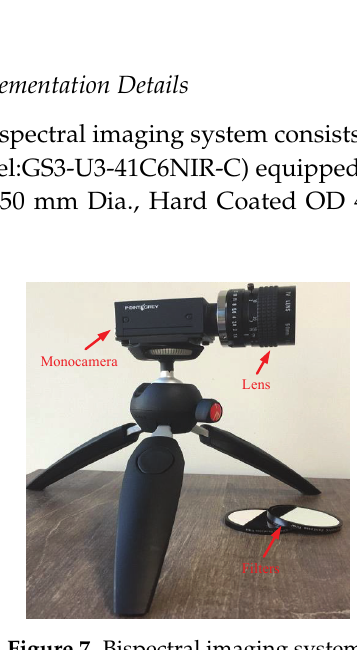
Figure 7. Bispectral imaging